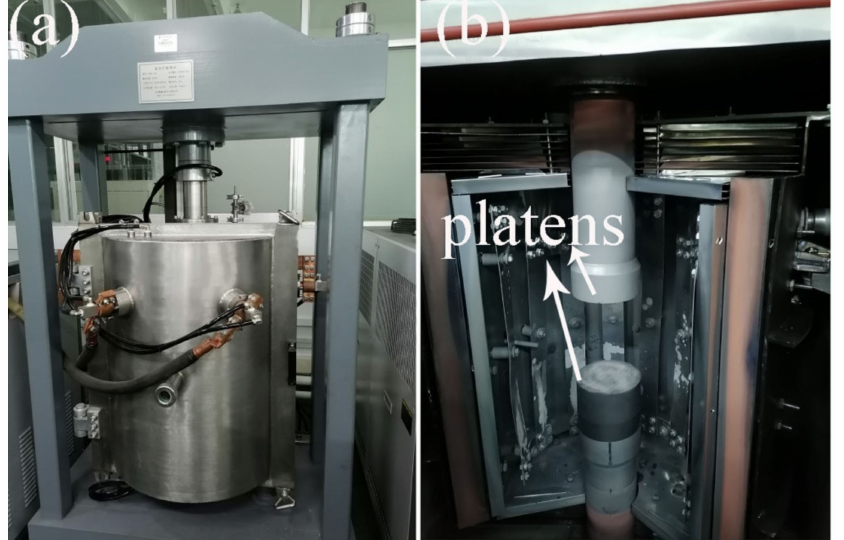
Figure 2. The image of the diffusion welding furnace with a loading system used in this study. ( a ) heating furnace; ( b ) loading